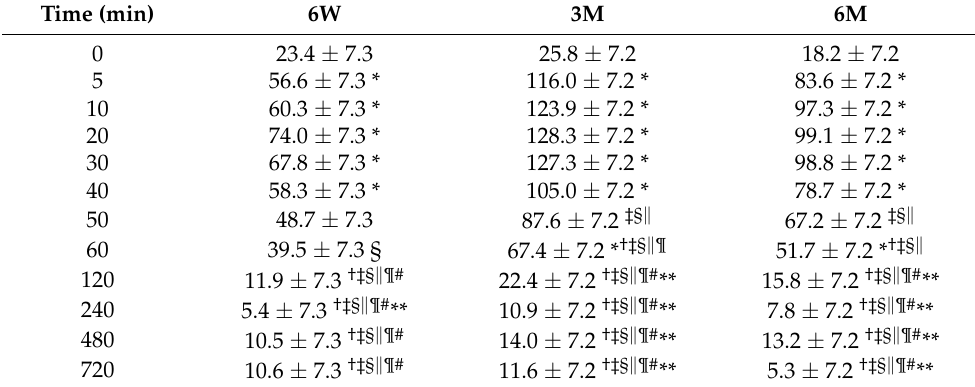
Table 1. Estimated least square means and standard error (SEM) of cortisol concentrations (nmol/L) in SHAM treatment at the different time points (min) for the calves of 6 weeks (6W), 3 months (3M) and 6 months (6M) of age, respectively.